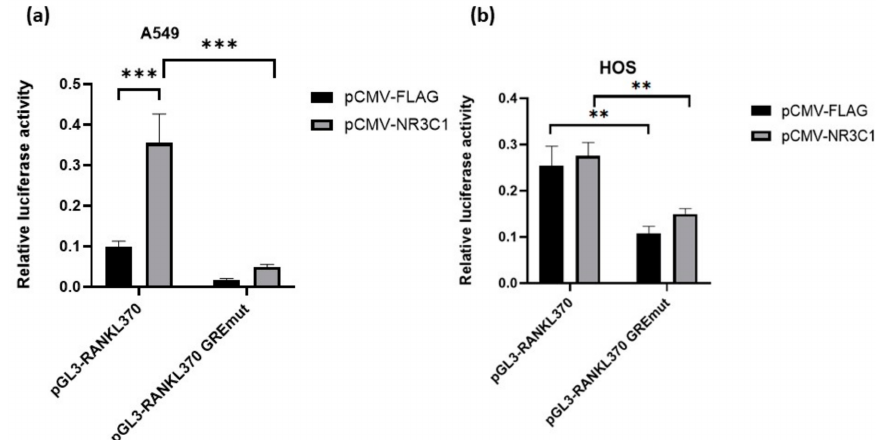
Figure 3. Mutation in Glucocorticoid Responsive Element alleviates effect of GR on RANKL promoter activity in A549 cells. ( a , b ) A549 and HOS cells were co-transfected with the luciferase reporter constructs harbouring RANKL promoter region pGL3-RANKL370 or plasmid with introduced mutation at GRE +352 site (pGL3-RANKL370 GREmut) and pCMV-NR3C1 or empty plasmid (pCMV-FLAG) and 24 h after transfection luciferase activity was measured. Relative luciferase activity is shown and it was calculated by normalization of Firefly luciferase activity to Renilla luciferase activity. All the experiments were performed at least three times independently in parallels. The results are expressed as the mean ± SEM. **– p < 0.01, ***– p <